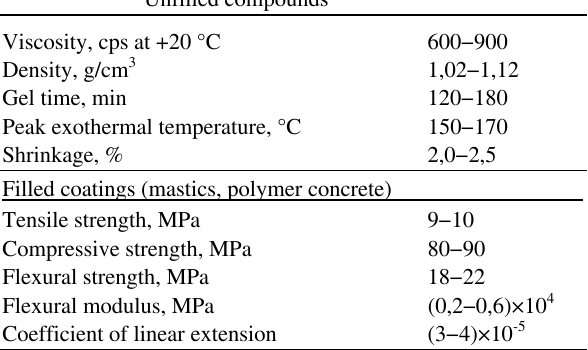
Table 1 . Properties of IKAS